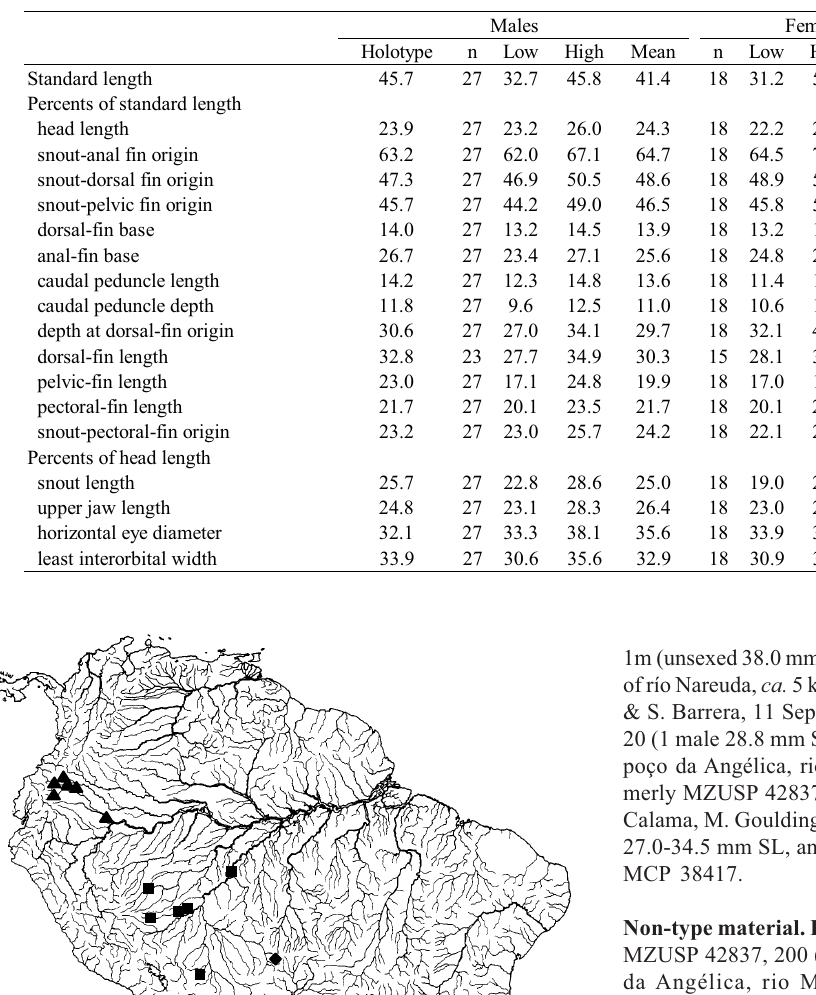
Table 2. Morphometrics of Odontostilbe ecuadorensis n. sp. (holotype ANSP 170608, 12 of ANSP 130574, 2 of MEPN 001517, 15 of KU 13524, 3 of KU 13526, 7 of FMNH 113511, 11 of FMNH 113513, 5 of FMNH